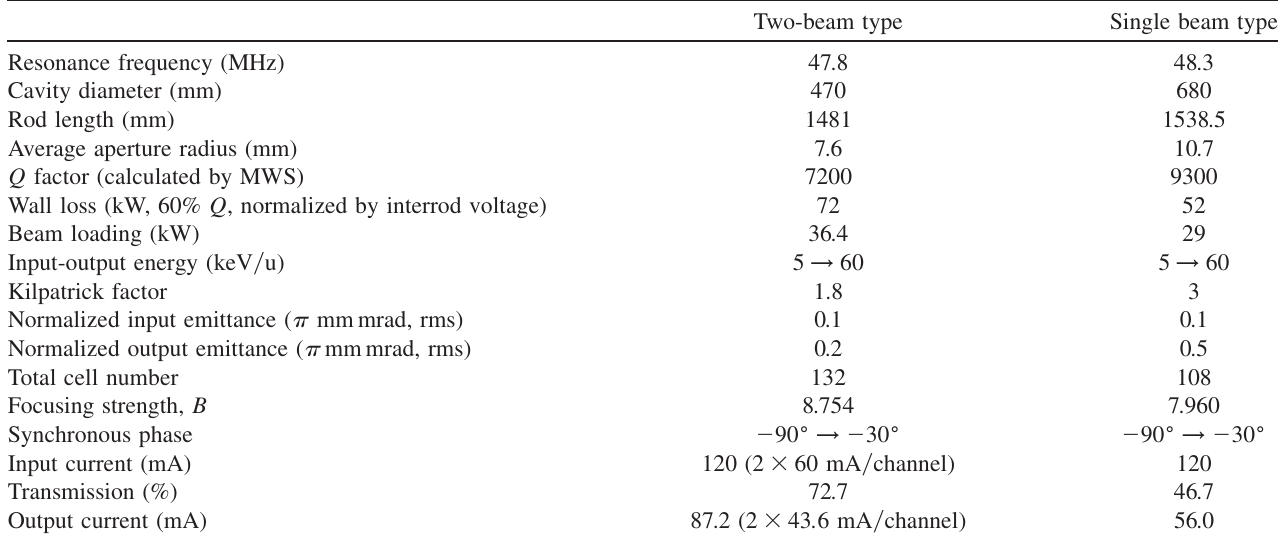
TABLE VIII. Main parameters comparison with single and two-beam type IH-RFQ linac for q=A ¼ 1 = 6 acceleration.